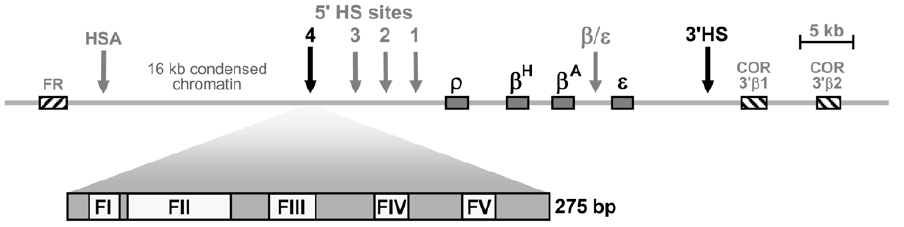
Figure 1. Schematic representation of the chicken b -globin cluster and surrounding loci. Boxes represent the folate receptor ( FR ), b -globin ( r , b H , b A and e ) and chicken olfactory receptor ( COR ) genes (not to scale). Arrows indicate DNaseI hypersensitive sites. The core of the HS4 element is expanded to show the positions of the five in vitro footprinted sequences [11].